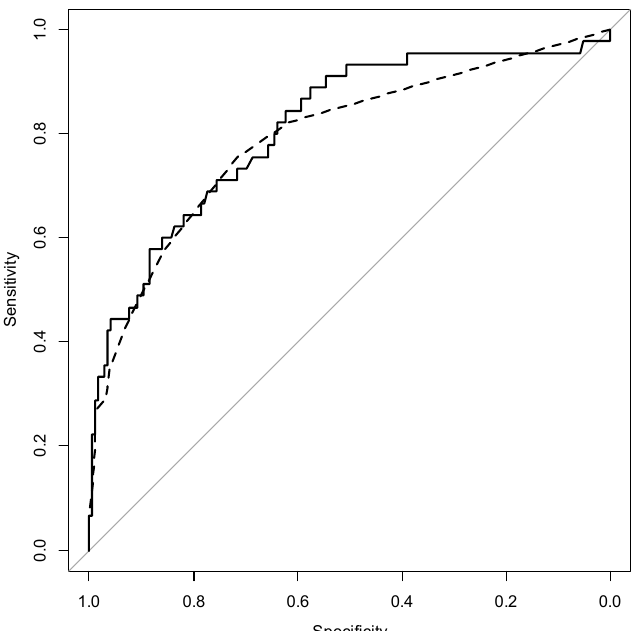
Figure 1. Comparison of ROC curves between the baseline model (dashed line) and the model in- cluding urinary protein (solid line).